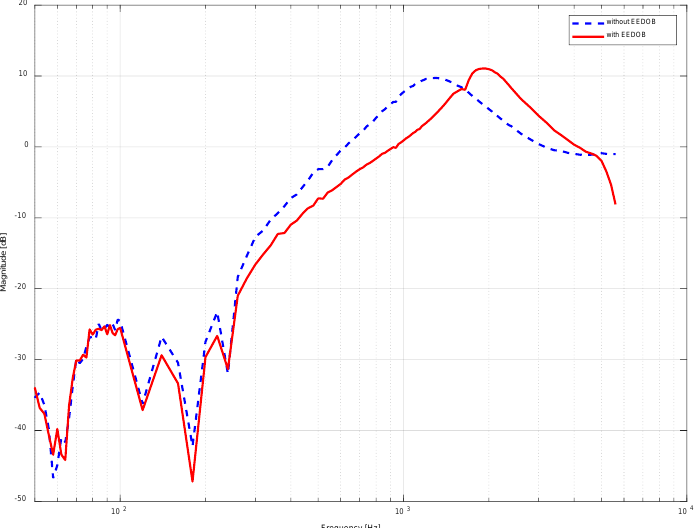
Figure 10. Output sensitivity functions from plant output disturbance to plant output.